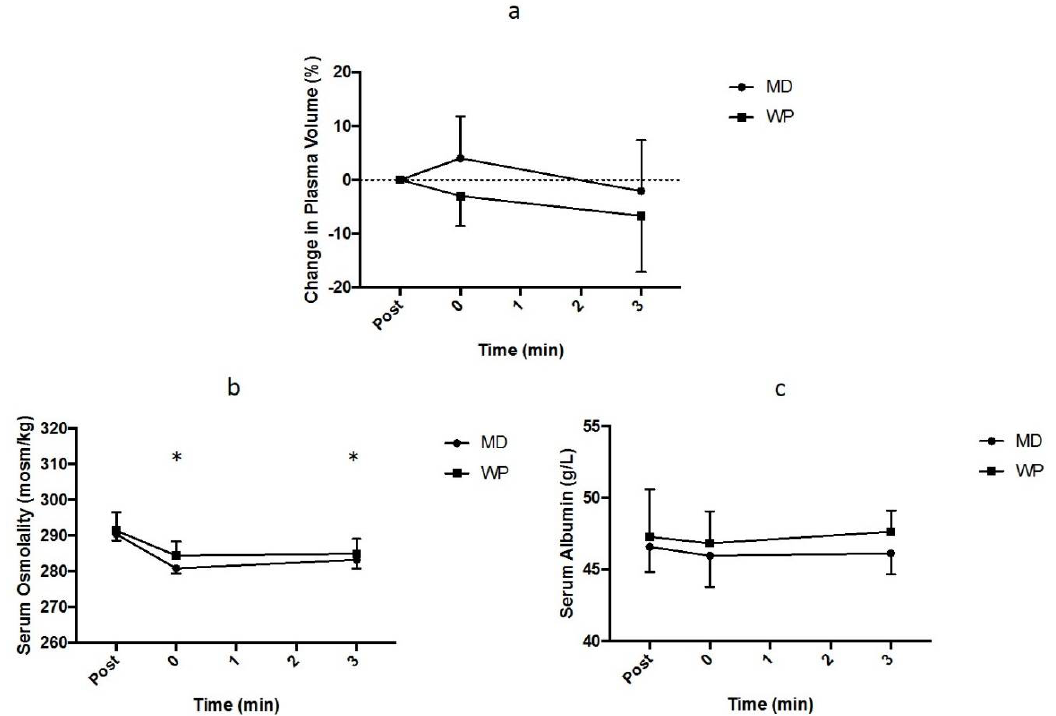
Figure 4. ( a ) Change in plasma volume (%) from post-exercise time points during the maltodextrin (MD) and whey protein (WP) trials. ( b ) The serum osmolality (mosm/kg) at each time point for the MD and WP trials. “*” indicates significantly difference ( p < 0.050) from post-exercise time point for the MD and WP trials. ( c ) Serum albumin concentration (g/L) at each time point during the MD and WP trials.